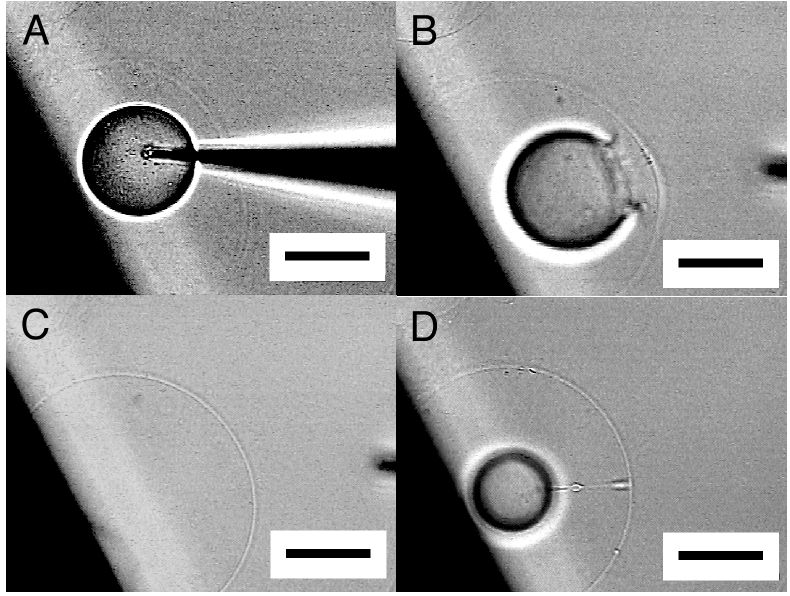
Figure 6. Unsuccessful microvesiculation. Images are a semi-sphere with bleeding Ficoll from inserted microneedle ( A ), immediately ( B ), and 10 s after the needle was pulled out ( C ). Sometimes, a tether connecting the inner and outer membranes could be seen ( D ). Bar = 50 μ m.